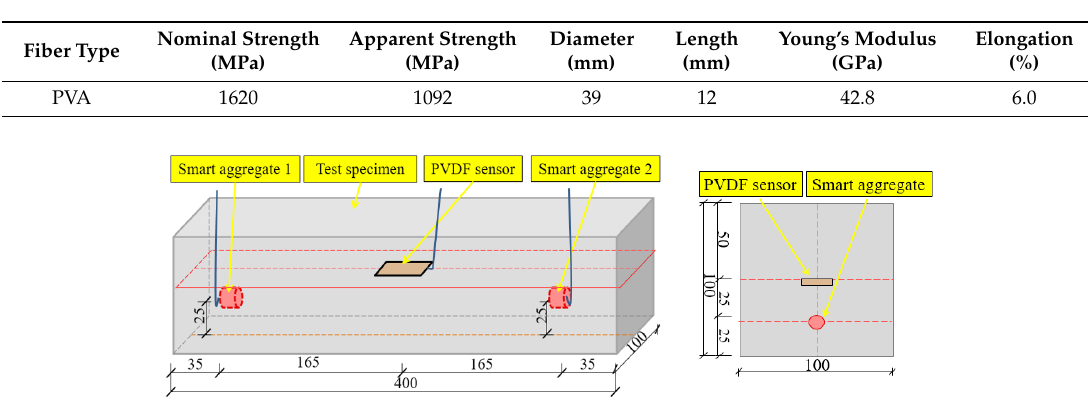
Figure 3. Detailed sensor location (unit: mm).